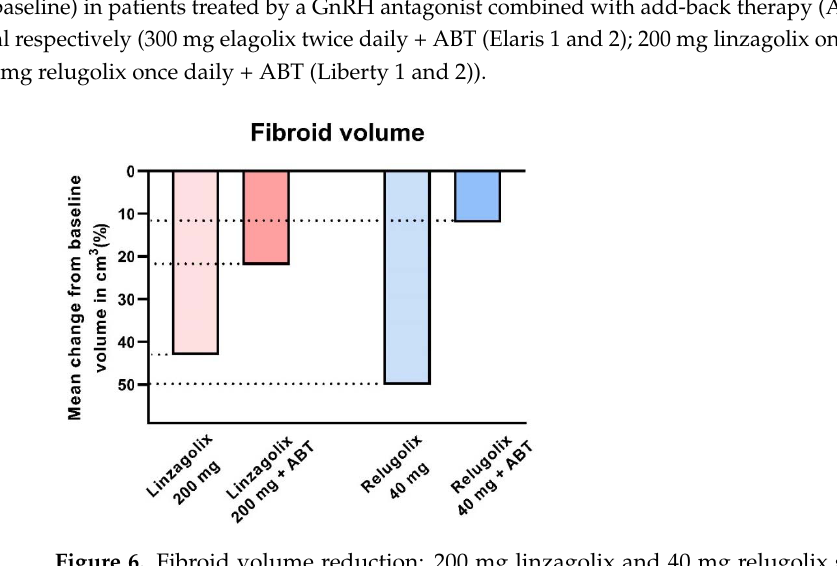
Figure 6. Fibroid volume reduction: 200 mg linzagolix and 40 mg relugolix significantly reduce myoma volume ( p < 0.001). The decrease was not significant when ABT was added.